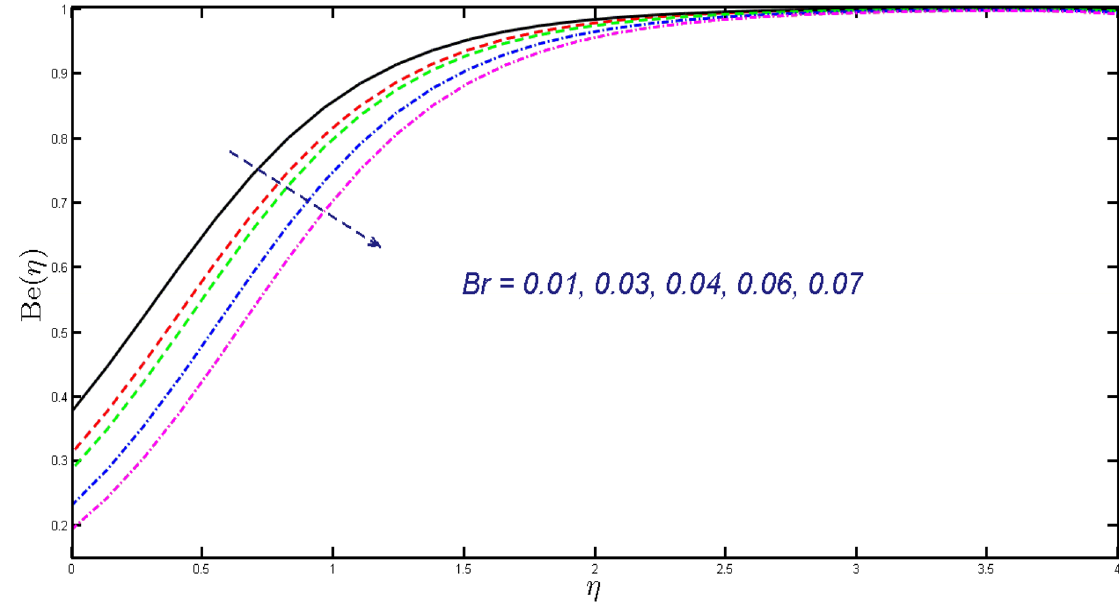
Figure 21. Field of Bejan number for Br .